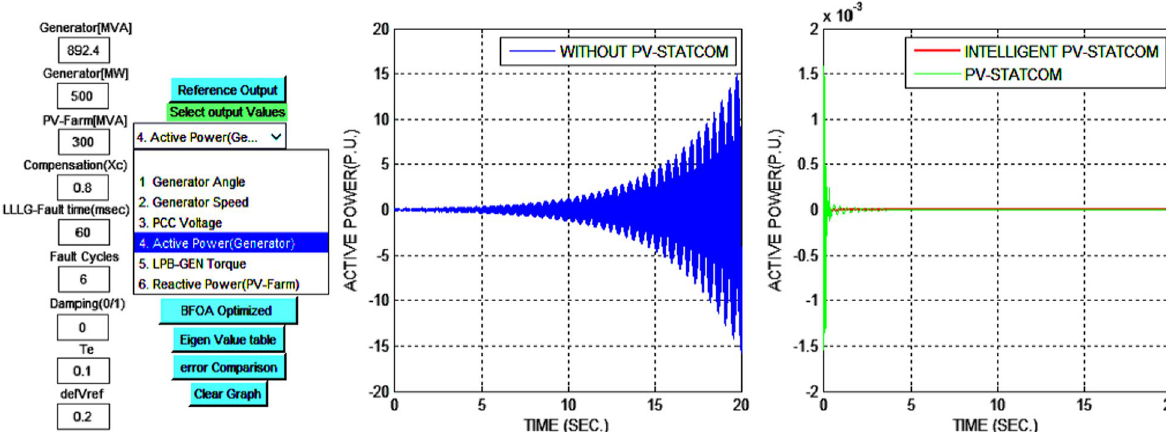
Fig. 13 Active power deviations